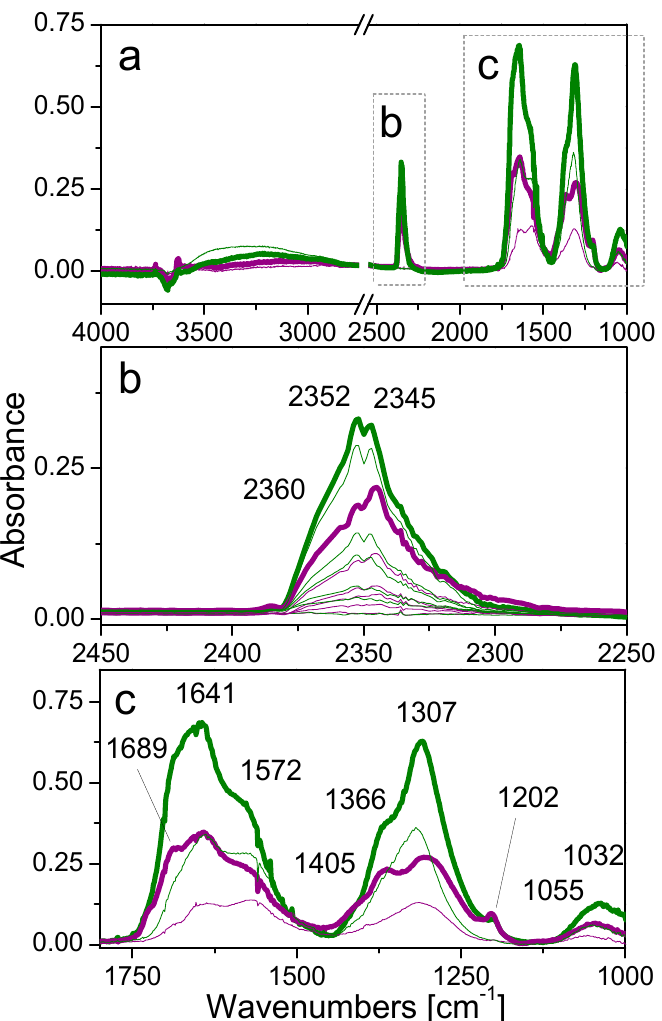
Figure 11. ( a ) FTIR difference spectra collected on CuO ‐ TiO 2 (green curves) and Au ‐ TiO 2 (violet curves) after the inlet of 15 mbar CO 2 at r.t. (bold curves) and subsequent outgassing at the same temperature for 30 min (fine curves). ( b ) Zoom on the 2450–2250 cm − 1 spectral range in which the spectra collected at decreasing CO 2 pressure and under outgassing at r.t. (fine curves). ( c ) Zoom on the 1800–1000 cm − 1 spectral range.